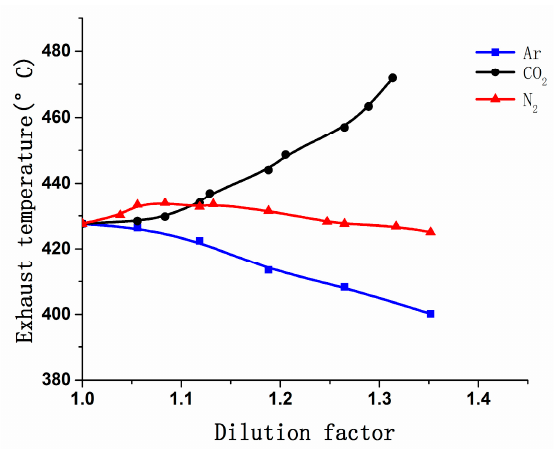
Figure 10. Variation in exhaust temperature vs. the DF of CO 2 , N 2 , and Ar.